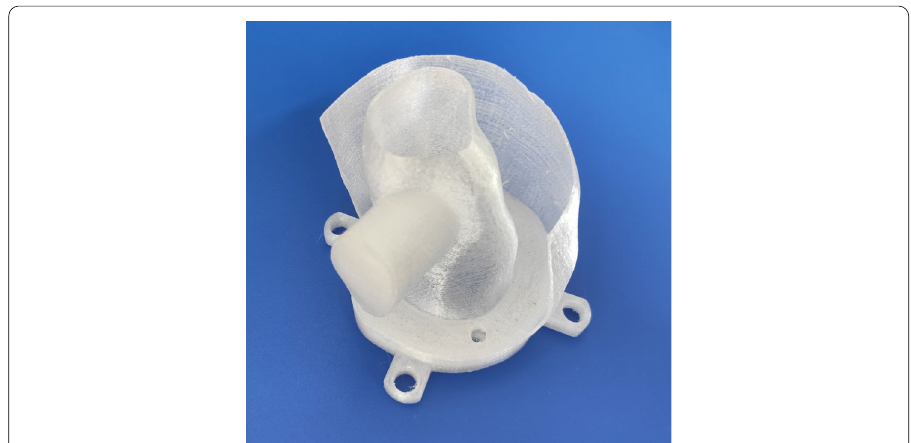
Fig. 2 Multi-sectional image of the real 3D printed LVm defective